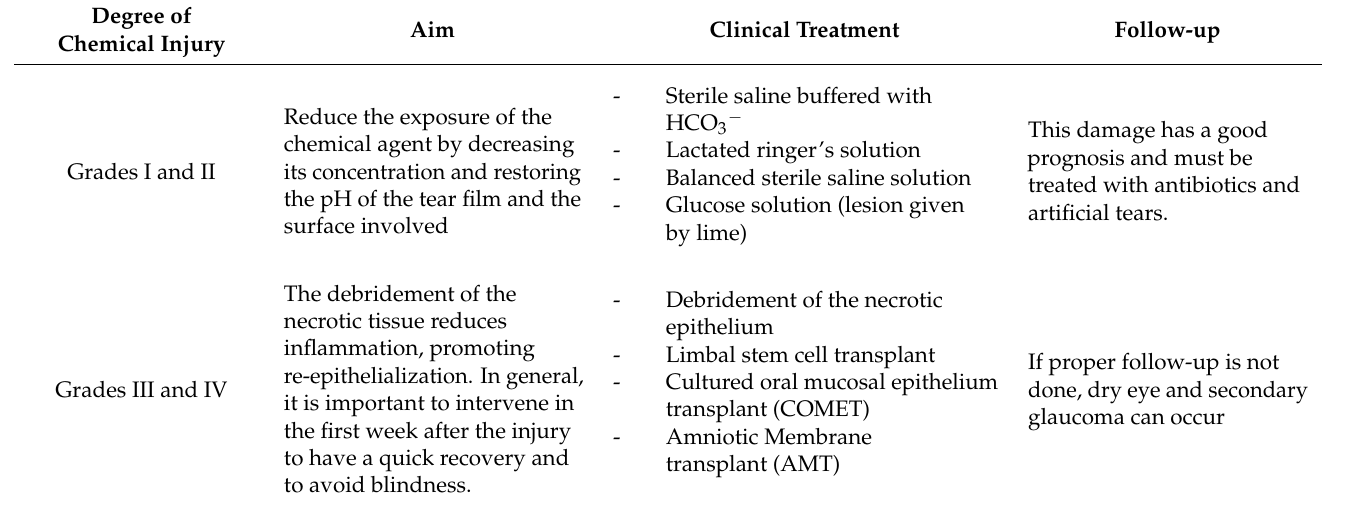
Table 1. Severity and depth of corneal damage and